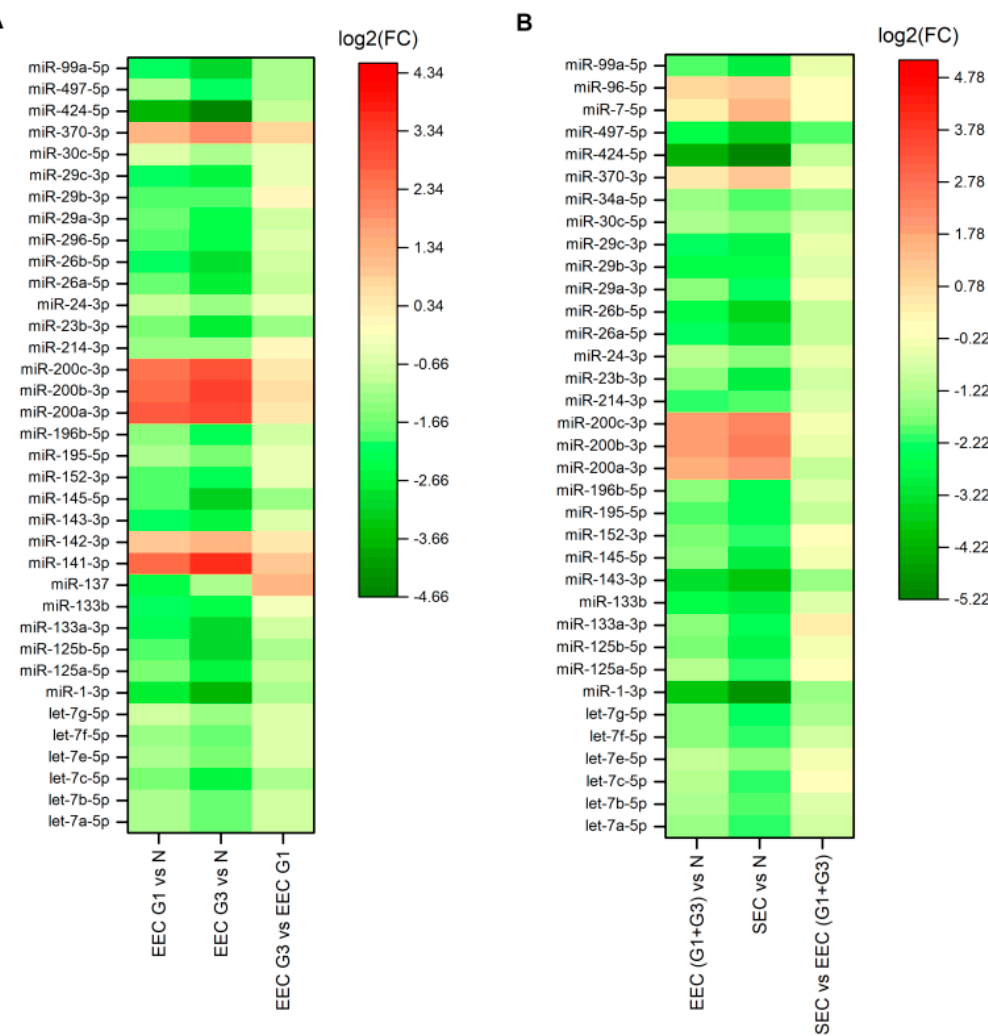
Figure 1. Heat maps of miRNA expression in endometrial cancer. Differences in miRNA expression between grade 1 (EEC G1) and grade 3 (EEC G3) endometrioid endometrial carcinoma compared with non-neoplastic endometrium (N), ( A ) and between endometrioid endometrial carcinoma (EEC (G1 + G3)) and serous endometrial carcinoma (SEC) compared with the non-neoplastic endometrium (N) ( B ). On the scale of fold regulation (log2(FC)), red corresponds to upregulated miRNAs and green corresponds to downregulated miRNAs.